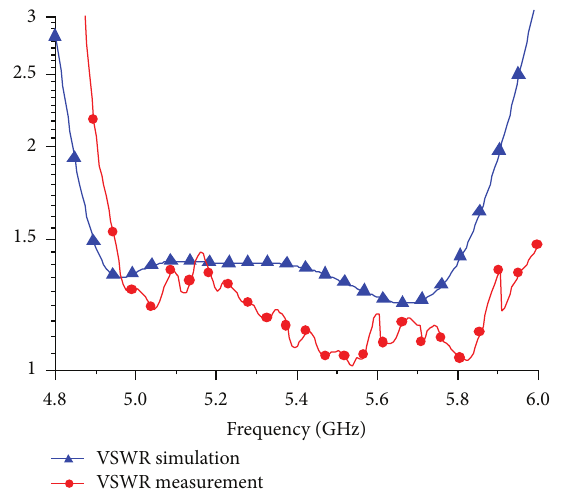
Figure 5: The VSWR of experimental array antenna.